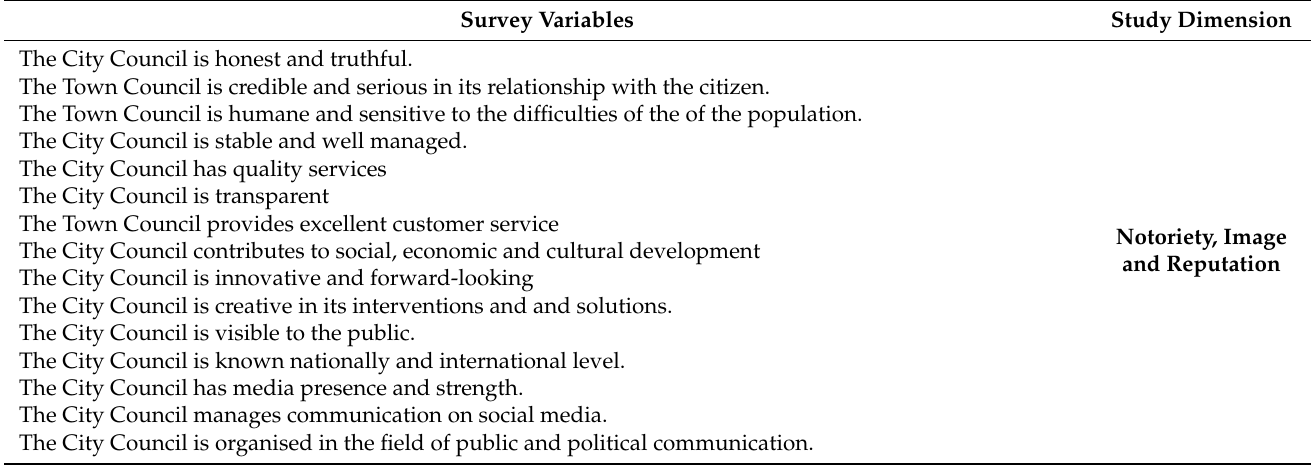
Table A1. Selection of Research